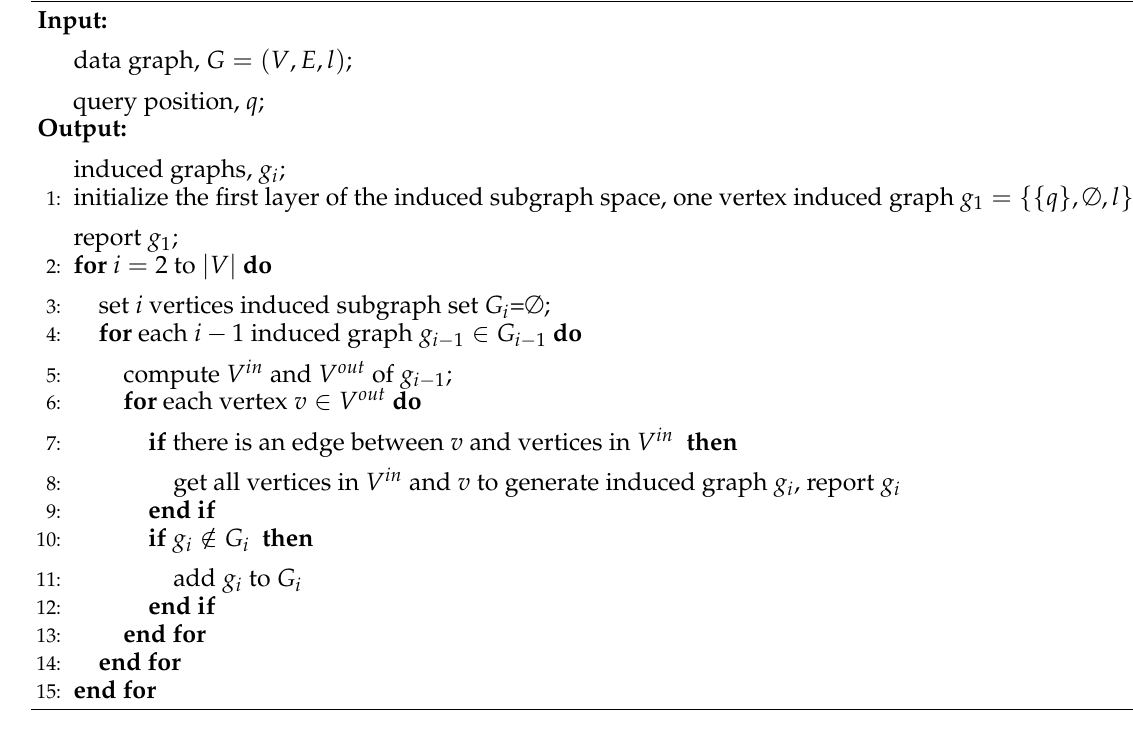
Algorithm 2 BFS-based candidate set generation